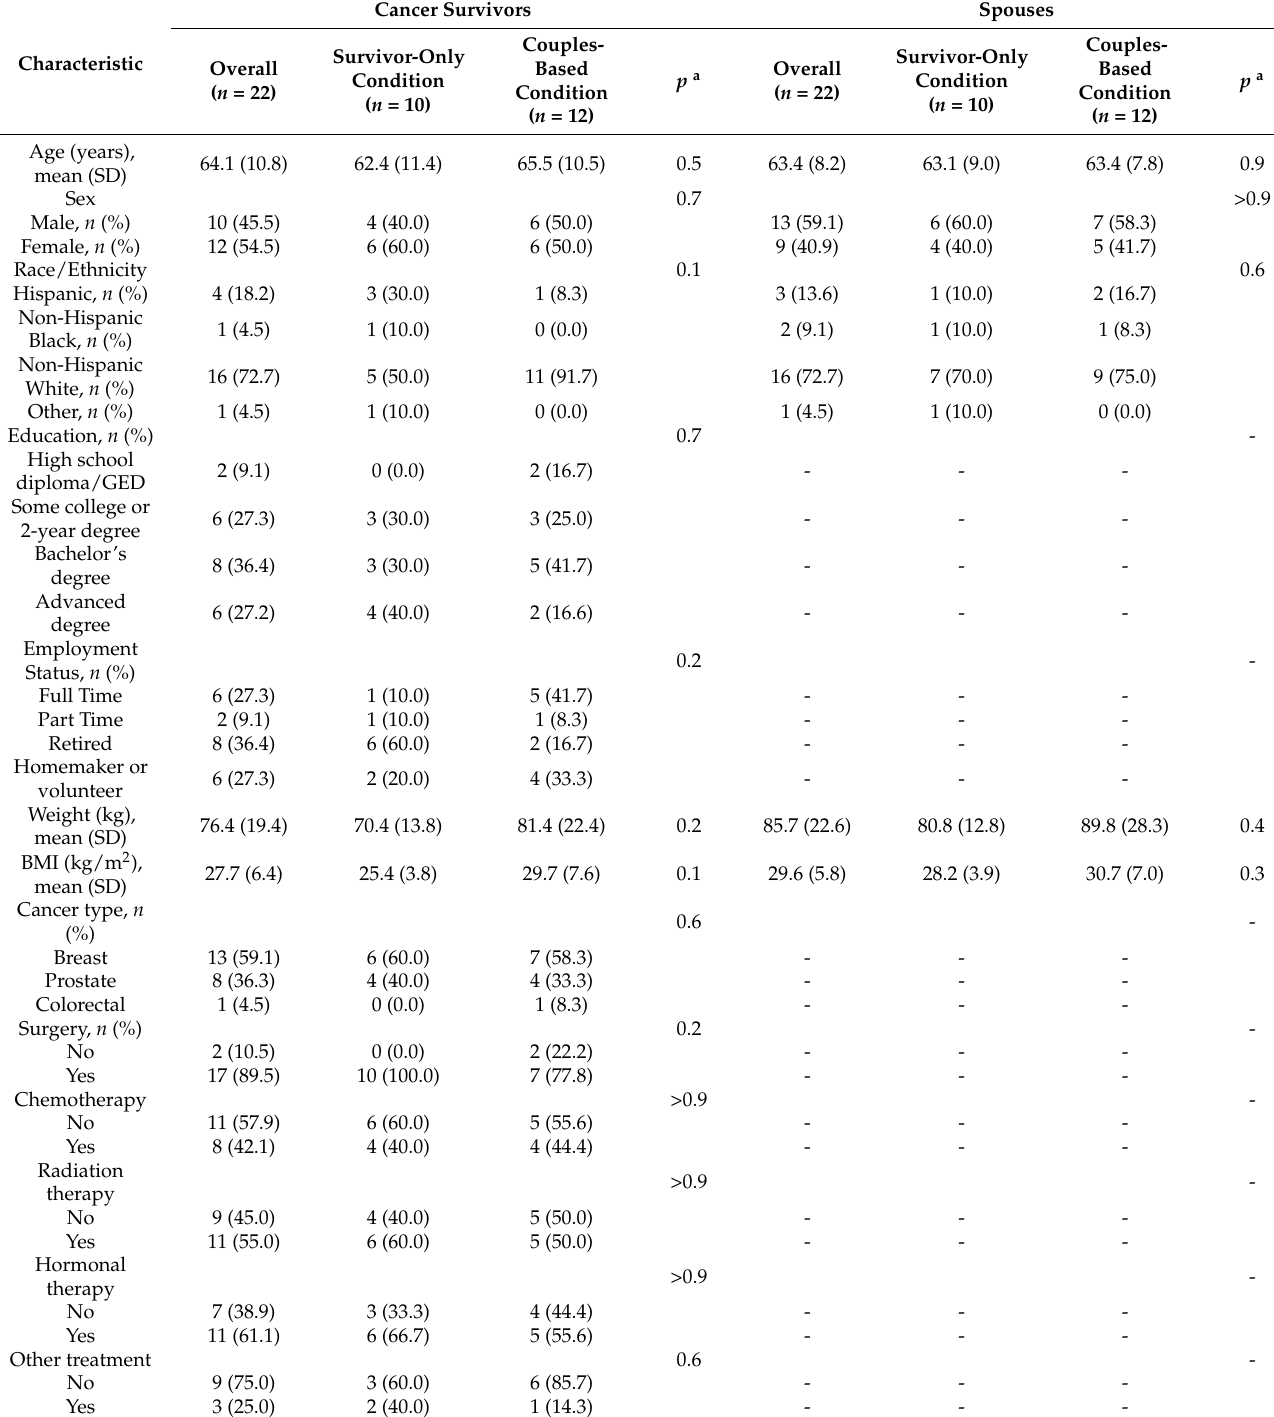
Table 1. Clinic demographic characteristics of cancer survivor and spouse participants by study